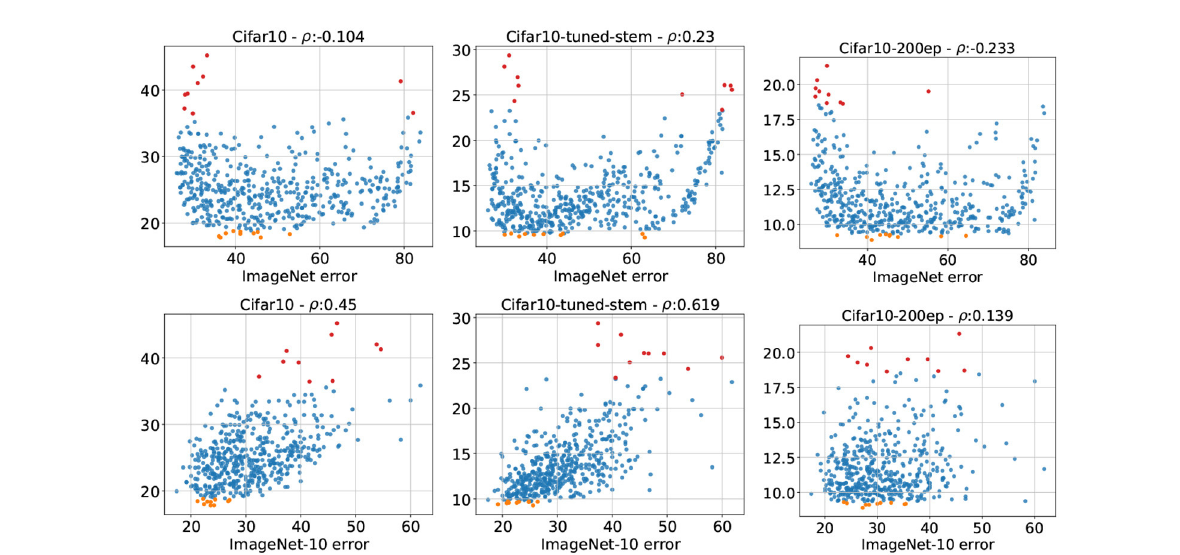
FIGUREA1 The Cifar10 test errors of all 500 architectures plotted against ImageNet (top row) and ImageNet-10 (bottom row) , shown for our original Cifar10 training (left column) , training with a Cifar10 specific stem in the architecture (middle column) , and training for 200 epochs, which is roughly 6 times longer (right column) . The plots show that the error correlation with ImageNet-10 is much larger in all three cases, confirming that optimizing for individual Cifar10 performance does not alter our core result.